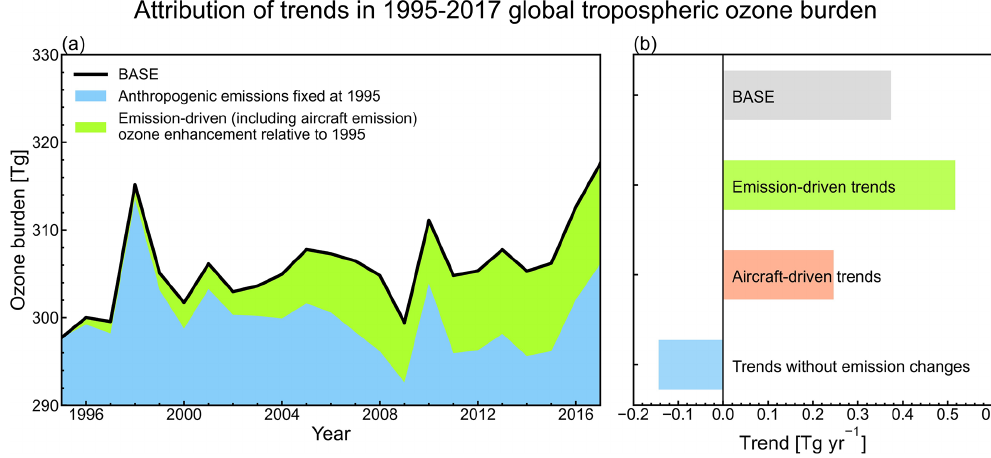
Figure 9. Drivers of global tropospheric ozone burden and trends from 1995 to 2017 estimated in the GEOS-Chem model. (a) Evolution of the GEOS-Chem simulated annual global tropospheric ozone burden (black line, same as Fig. 8a) in the BASE simulation. The blue shadings show the evolution of tropospheric ozone burden from the FixAC simulation, estimating ozone burden if anthropogenic emissions (surface emissions, aircraft emissions, and methane) are fixed at the level of 1995. The green shadings thus estimate the tropospheric ozone burden contributed by the anthropogenic emission (including aircraft emission) changes relative to the 1995 level. (b) The estimated tropospheric ozone trends from the BASE simulation and from different drivers.